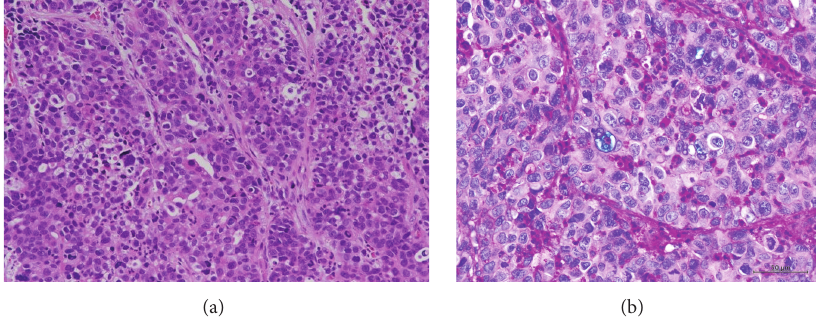
Figure 3: (a) Hematoxylin and eosin (HE) staining showed outgrowth of cells containing swollen nuclei to a solid tumor which was observed, with a few gland duct-like structures ( × 400). (b) Alcian-blue staining-positive mucus production was observed, suggesting poorly differentiated adenocarcinoma ( ×